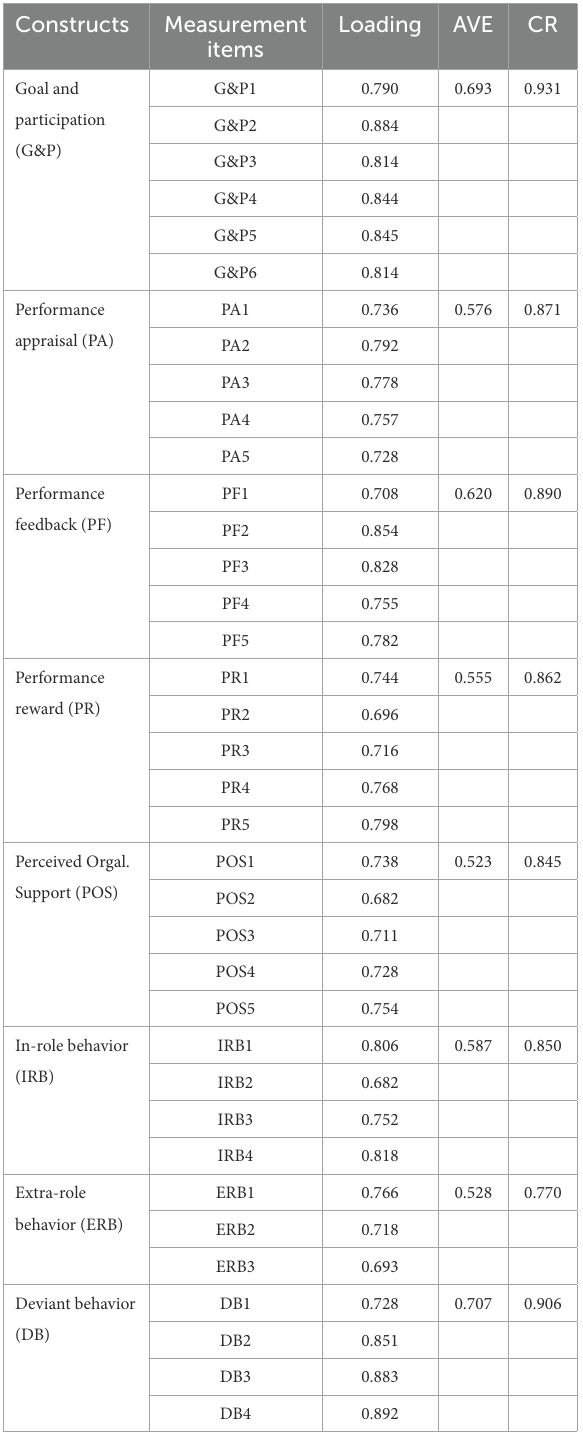
TABLE 3 Result of the measurement